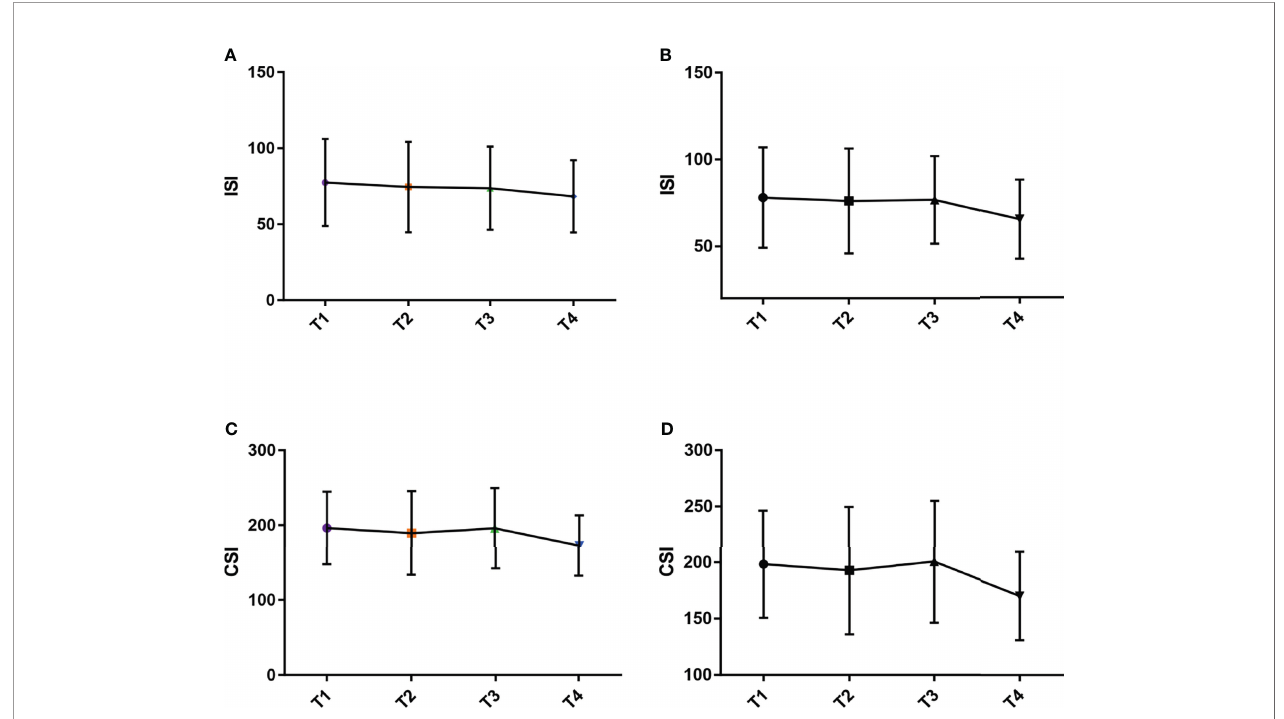
FIGURE 1 | Correlation between ISI, CSI and T staging. (A) ISI in all patients. (B) ISI in patients without DM. (C) CSI in all patients. (D) CSI in patients without